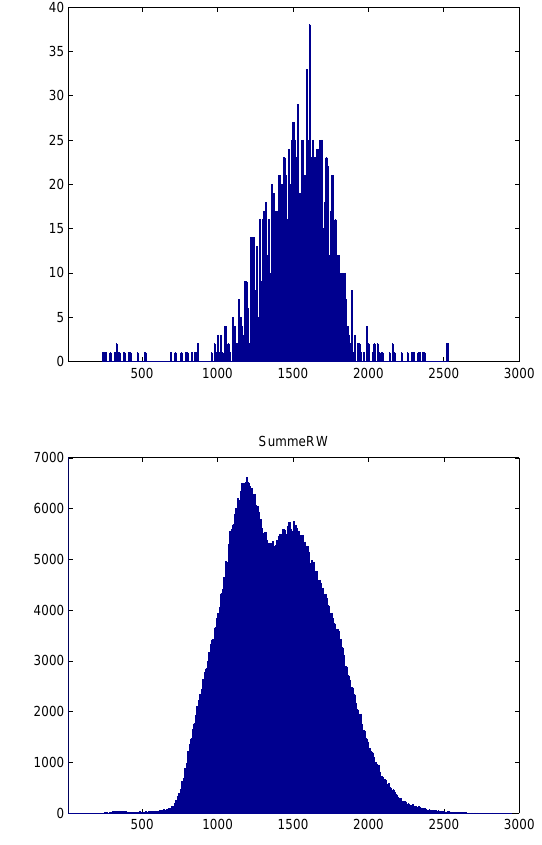
Figure 5: Histogram of the integrals of all eligible reference waveforms (top), histogram of the integrals of all waveforms